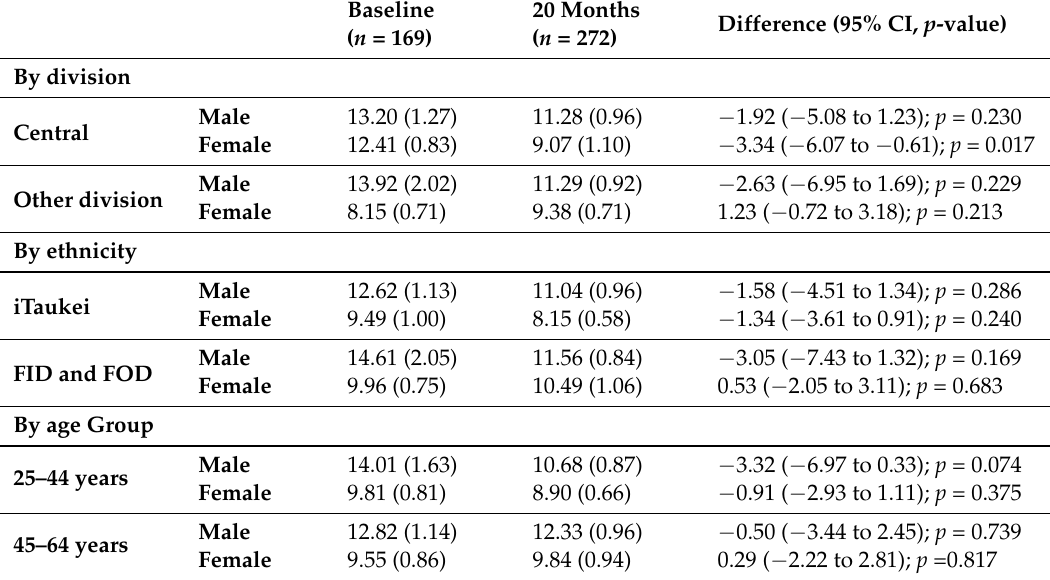
Table 4. Changes in salt intake disaggregated by gender (mean, SE) by division, ethnicity and age. Baseline